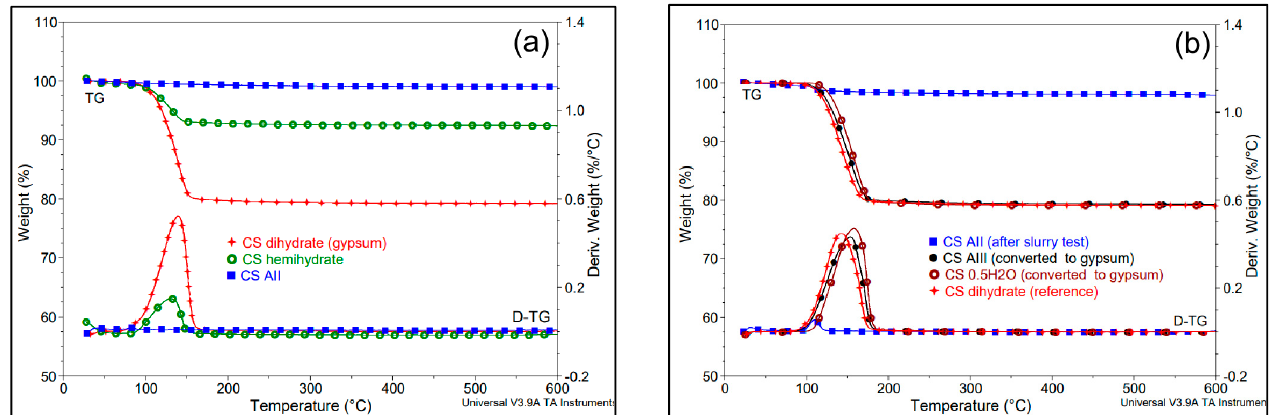
Figure 5. ( a , b ). Comparative TG and D-TG traces (20 °C/min, under N 2 ). ( a ) CS hydrated forms (dihydrate and hemihydrate) and AII; ( b ) samples recovered after the slurry tests: CS (AII) after 24 h mixing in water as slurry; CS (AIII) converted to gypsum; CS hemihydrate converted to gypsum; CS dihydrate (reference).